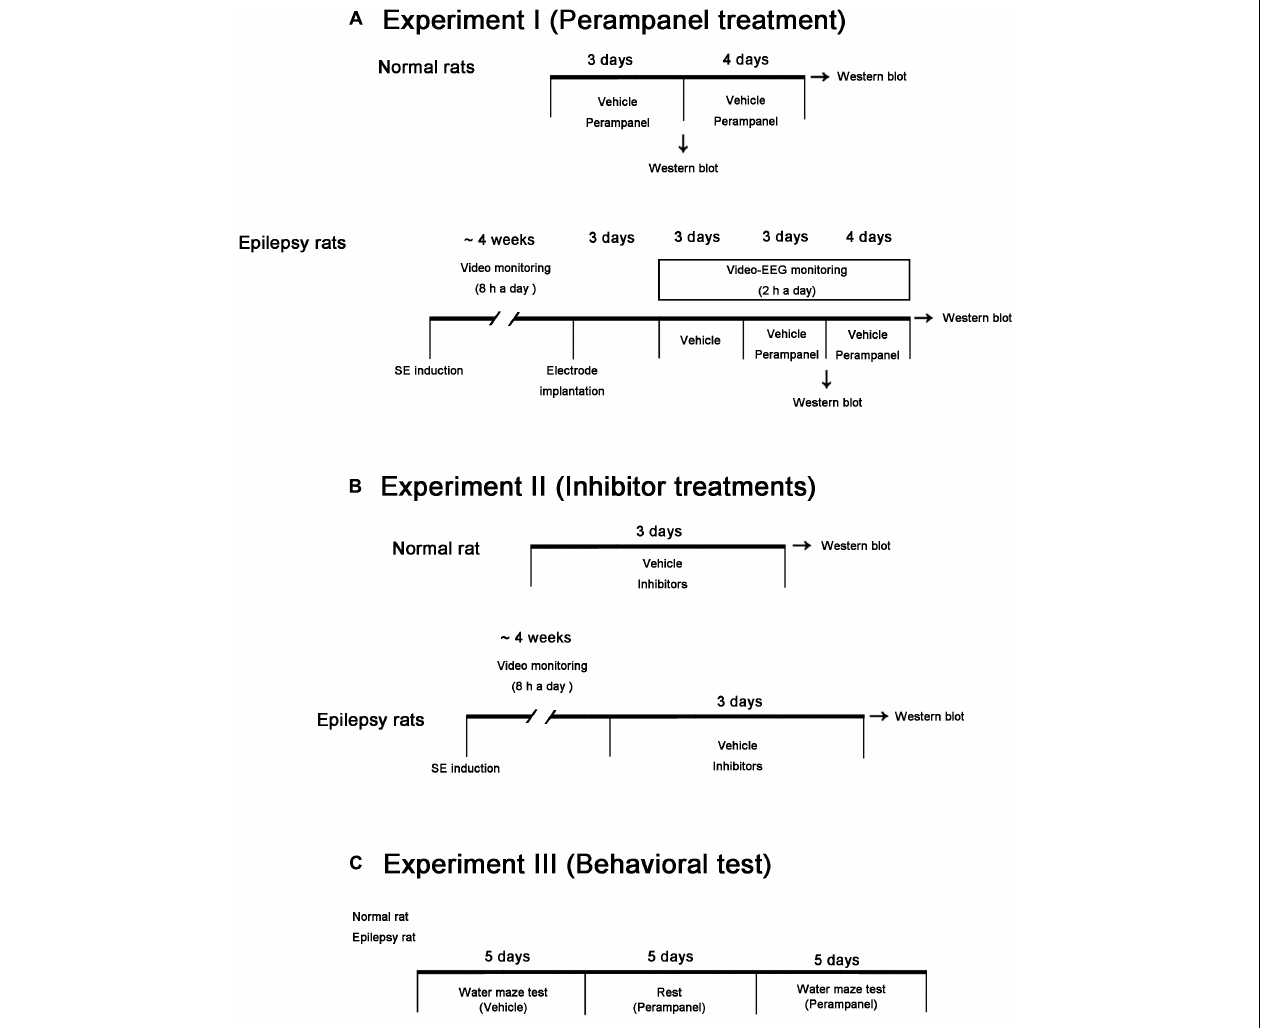
FIGURE 1 | Scheme of the experimental designs in the present study. (A) Studies for evaluation of the effects of perampanel on expressions/phosphorylations of GluA1, kinases and PPs in normal and epileptic rats. (B) Studies for validation of the effects of kinase and PP inhibitors on GluA1 expression and phosphorylations in normal and epileptic rats. (C) Protocols for measurement of cognitive effects of perampanel by water maze test.